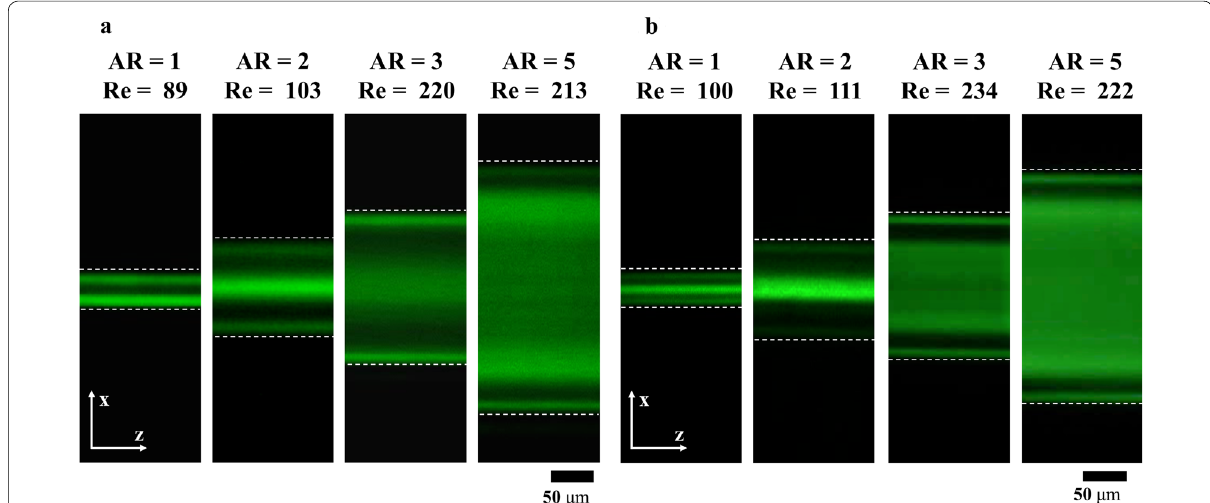
Fig. 4 Fluorescence images of particle distribution for a parallelogram profiled microchannels, and b rectangular microchannels with AR